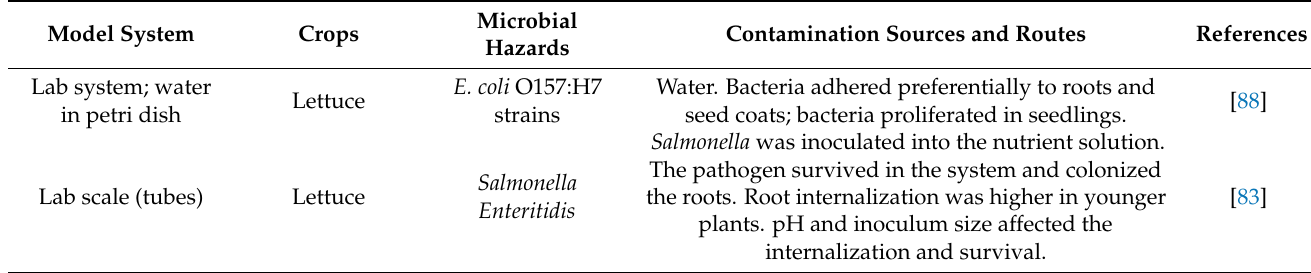
Table 2. Fate of human pathogens in model and experimental